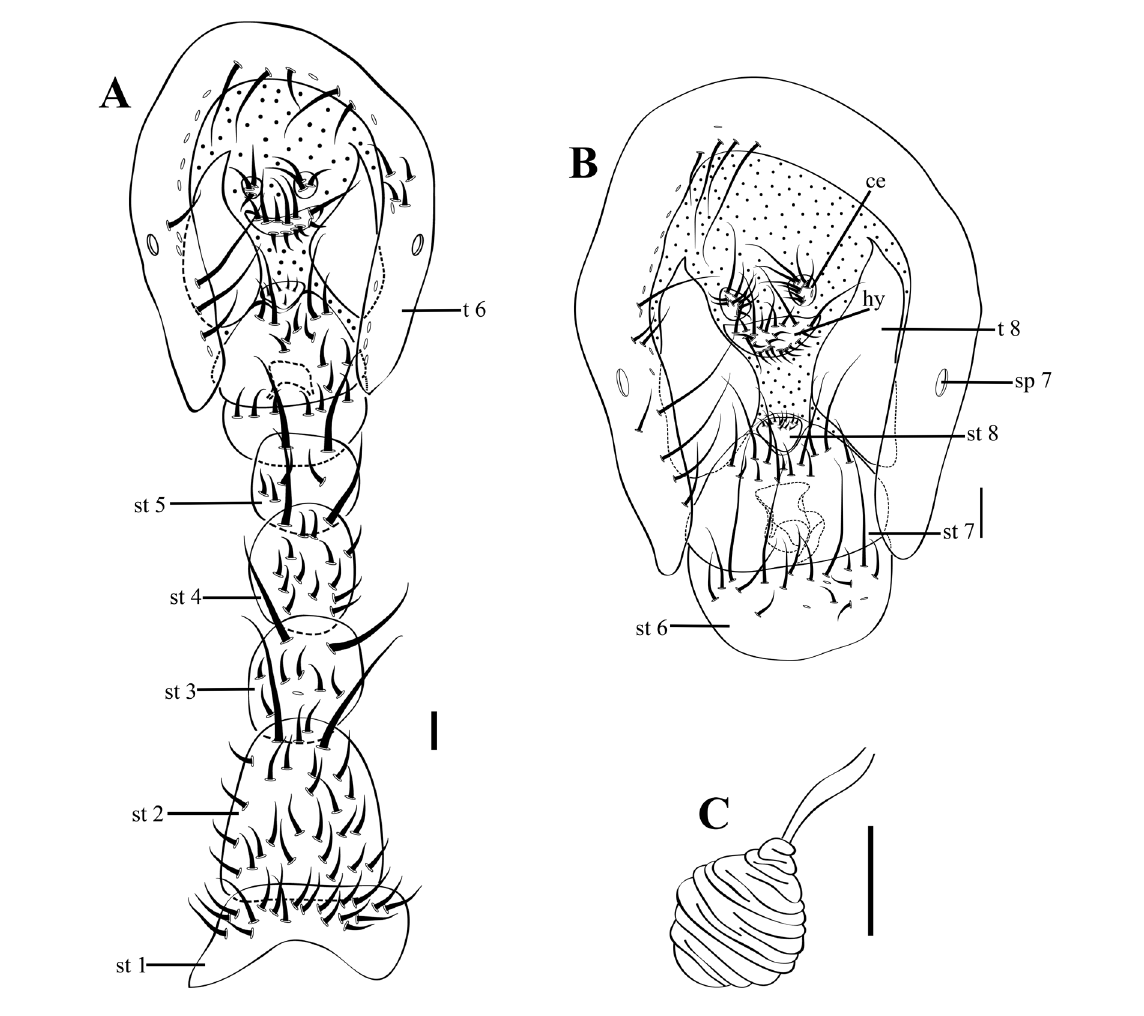
Fig. 10. Dexosarcophaga sphaera sp. nov., ♀, paratype (MNRJ [lost]), Brazil, Brasília, Distrito Federal, Fazenda Vargem Bonita). A . Terminalia and abdominal sternites, ventral view. B . Terminalia, ventral view. C . Spermatheca, lateral view. Abbreviations: see Material and methods. Scale bars = 0.1